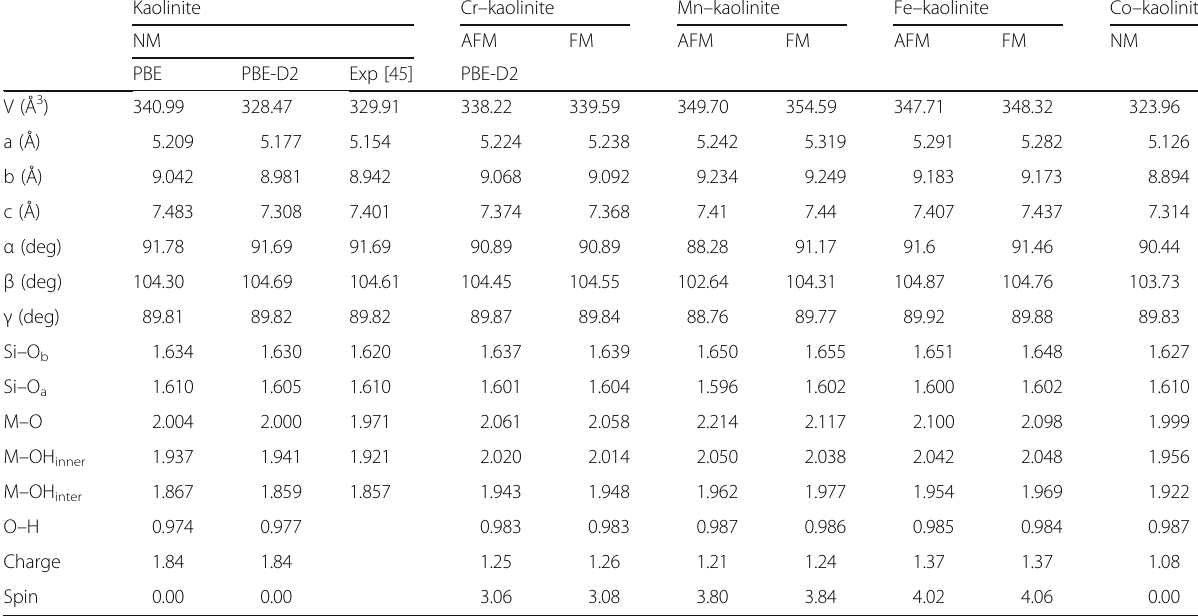
Table 1 Calculated and experimental unit cell parameters (Å) and averaged bond lengths (Å) of kaolinite and the most stable TM – kaolinite structure with AFM, FM, and NM states. The M – O bond represents the Al – O bond for kaolinite or the TM – O bond for TM – kaolinite. The average charge and spin of M atoms are also given Kaolinite Cr – kaolinite Mn – kaolinite Fe – kaolinite Co – kaolinite NM AFM FM AFM